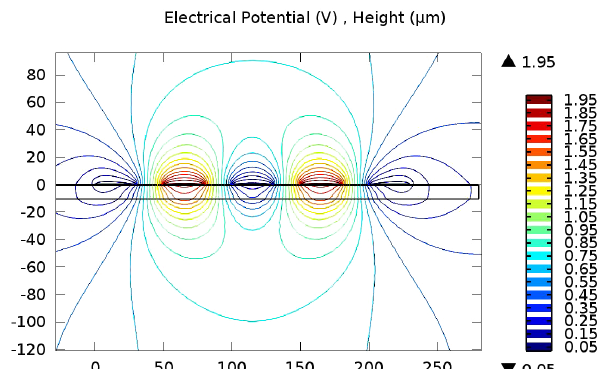
Figure 4. Simplified stray field model of structure with 2.2mm diameter for simulating the area of high electrical fields (in this case about 50µm above the